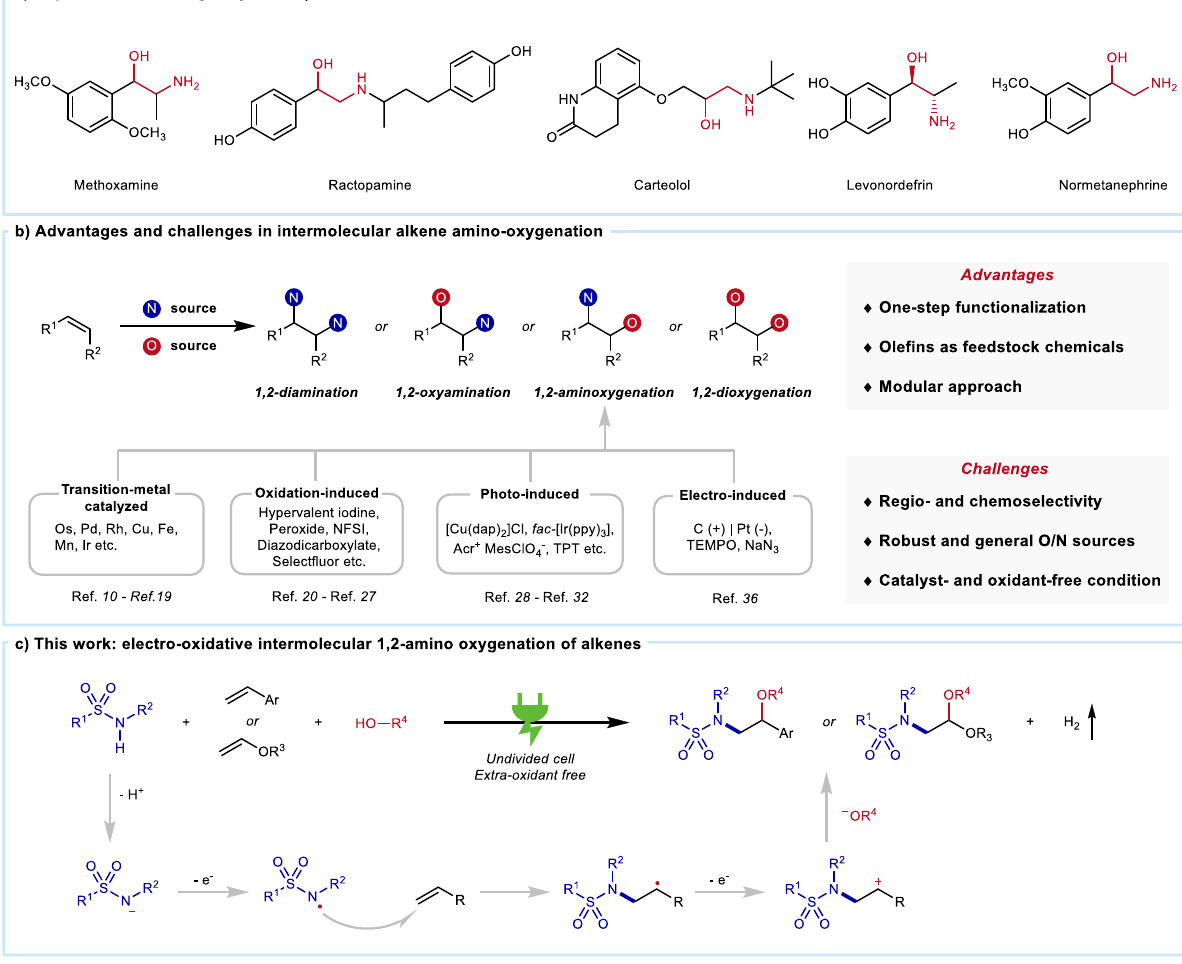
Fig.1|Introduction.a Representativebiologicallyactive β -aminoalcohols. b Advantagesandchallengesinintermolecularalkenes1,2-aminooxygenation. c Outlineofthis work: electro-oxidative 1,2-amino oxygenation of